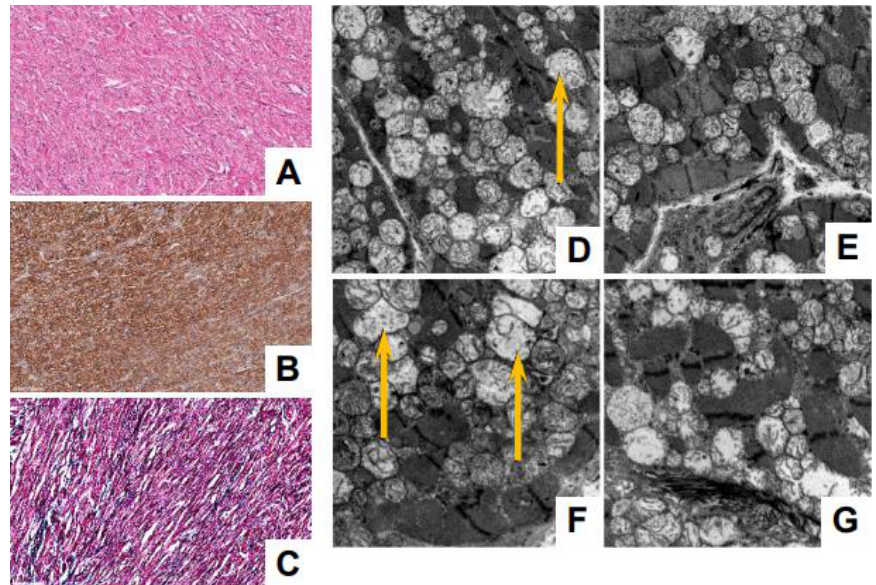
Figure 4. Histological and ultrastructural analyses of cardiac tissue from P2. ( A – C ) Light microscopy evaluation indicates a preserved architectural myocardial pattern, free of fibrosis and calcifications. (B) Immunohistochemical staining with desmin, showing normal preservation of this intermediate muscle-specific filament. Scale bar = 100 µm. ( D – G ) Ultrastructural analysis indicates myocardial fibers that show the preserved architecture of the sarcomeric elements; the mitochondria demon- strate reduced and irregular cristae (magnifications: E = 4800×; FG = 6800×). ( D , F ) Extensive mito- chondrial loss of cristae, with some mitochondria almost completely devoid of them, as indicated by arrows (magnification: D = 4800×).